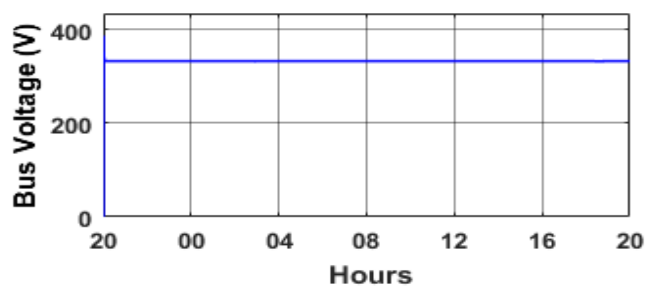
Figure 21. Voltage at the DC bus.